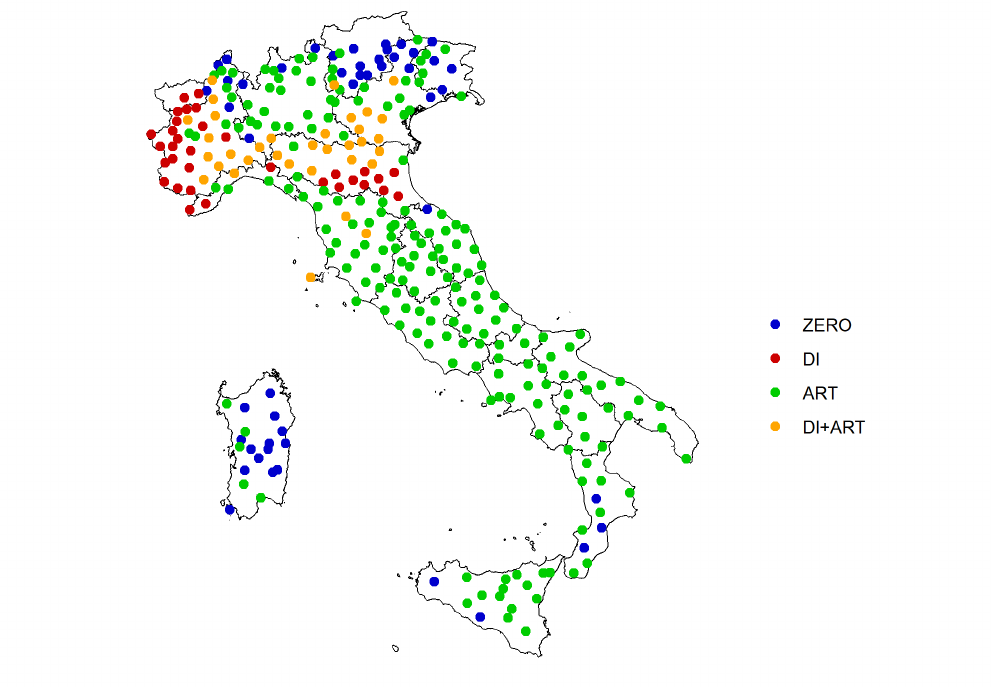
Figure 2. Rendering of the AIS map number 1343, showing the distribution of the use of the four determiners in the sentence “[to go to the cellar] to take